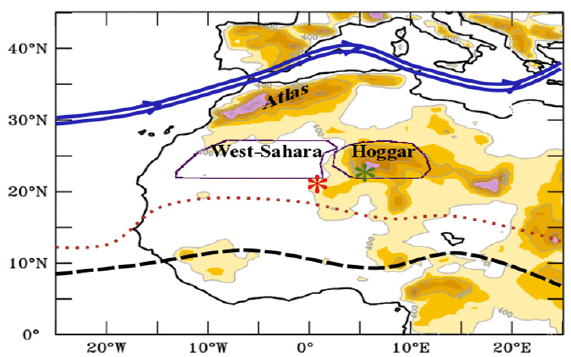
Figure 1. Map of West Africa with relief, July position of sub-tropical westerly jet (STWJ, blue line) [22], maximum monthly mean rainfall (dashed black line) [22], northernmost position of monthly mean rainfall > 25 mm (dotted red line) [22], the contours of the West-Sahara and Hoggar regions (garnet), the Tamanrasset meteorological station (green star) and the supersite-1 of Bordj Badji Mokhtar during the Fennec experiment (red star). For the altitude, the isolines are given every 200 m from 400 m. Altitude above 1200 m (light purple).